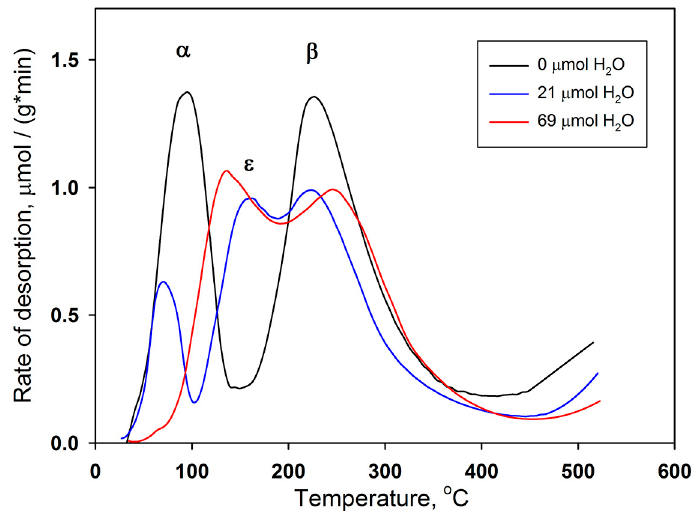
Figure 10. TPD curves of oxygen obtained after procedures consisting in oxygen adsorption after pre-adsorption of different quantity of water (0, 21 or 69 μ mol/g Co 3 O 4 ). Adapted from [34].